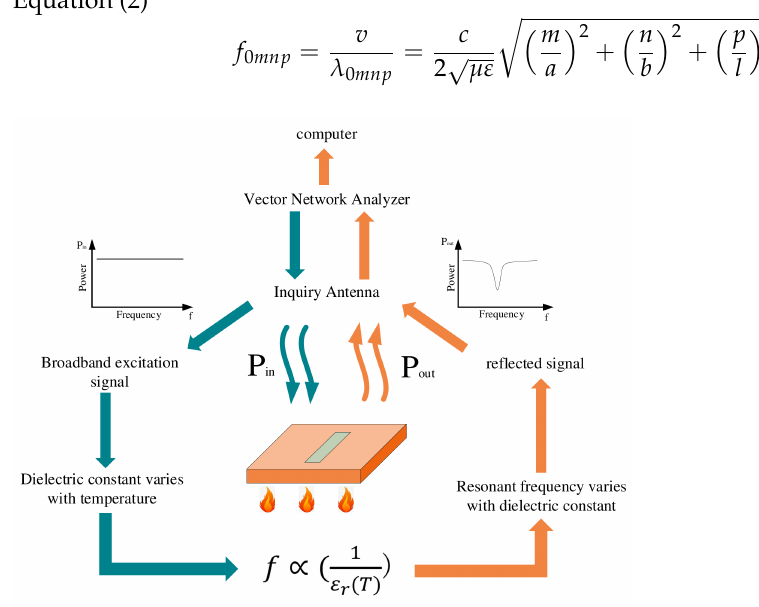
Figure 1. The working principle of the temperature sensing